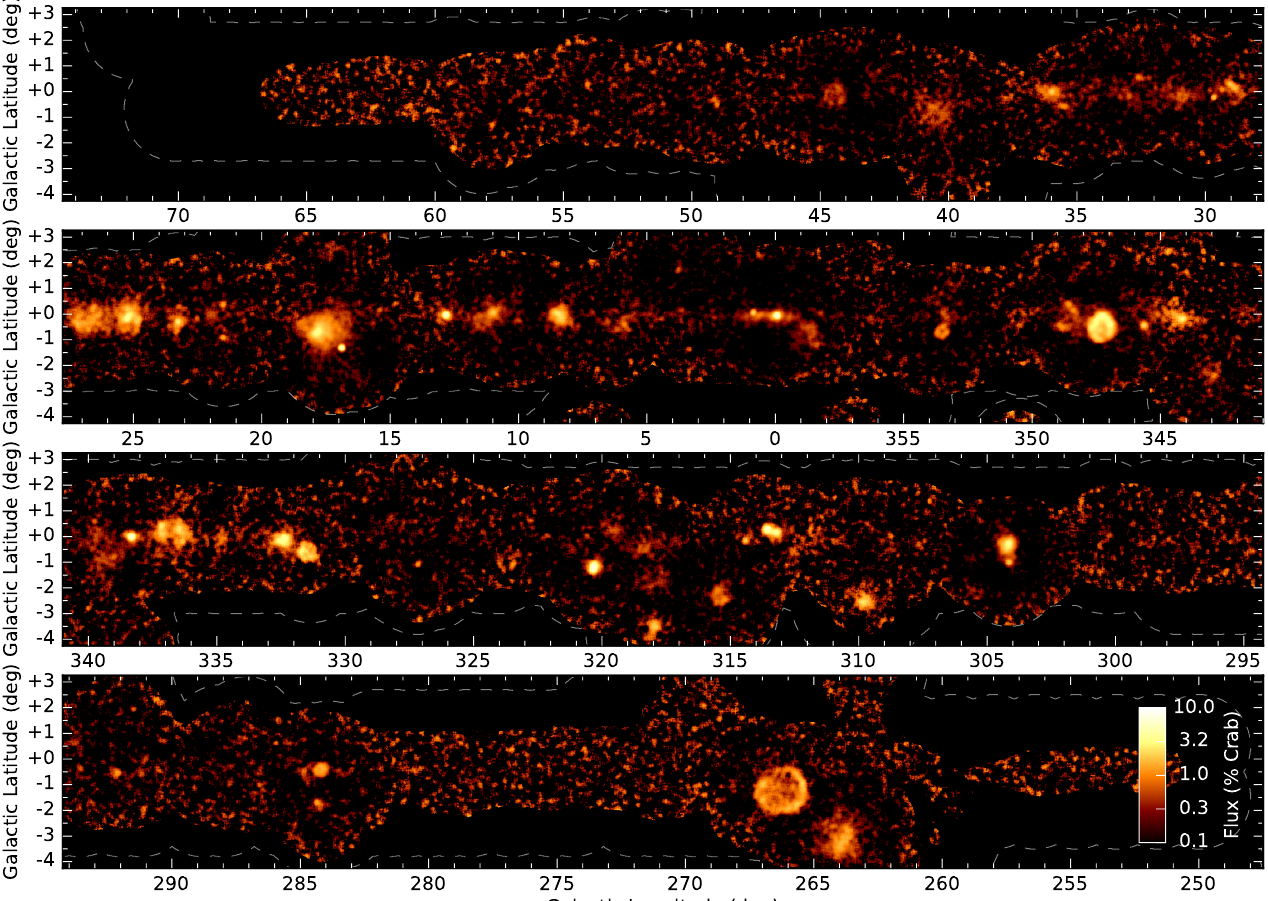
Figure 14. H.E.S.S. Galactic Plane Survey: Integral flux above 1 TeV. Reproduced from [18]. H.E.S.S. also performed a deep survey of the large magellanic cloud [34], with 210 h of data. Although the LMC is located much further away than the Galactic Centre,